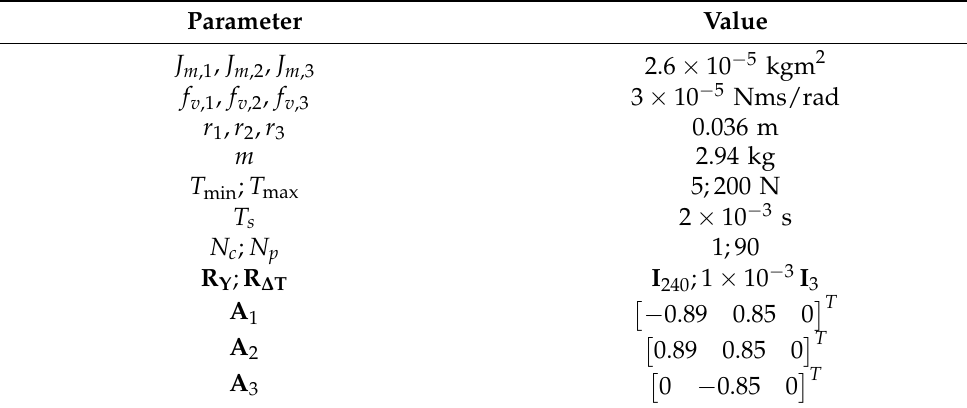
Table 1. Parameters of the CSPR and of the